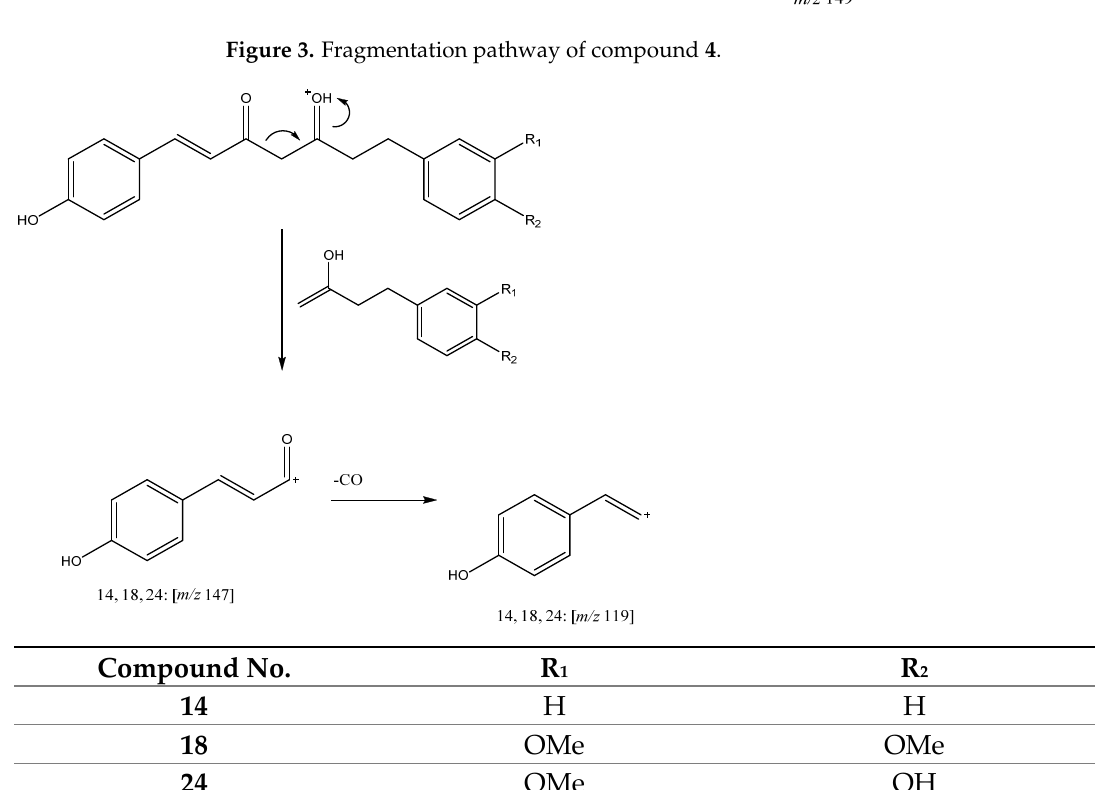
Figure 3. Fragmentation pathway of compound 4 .